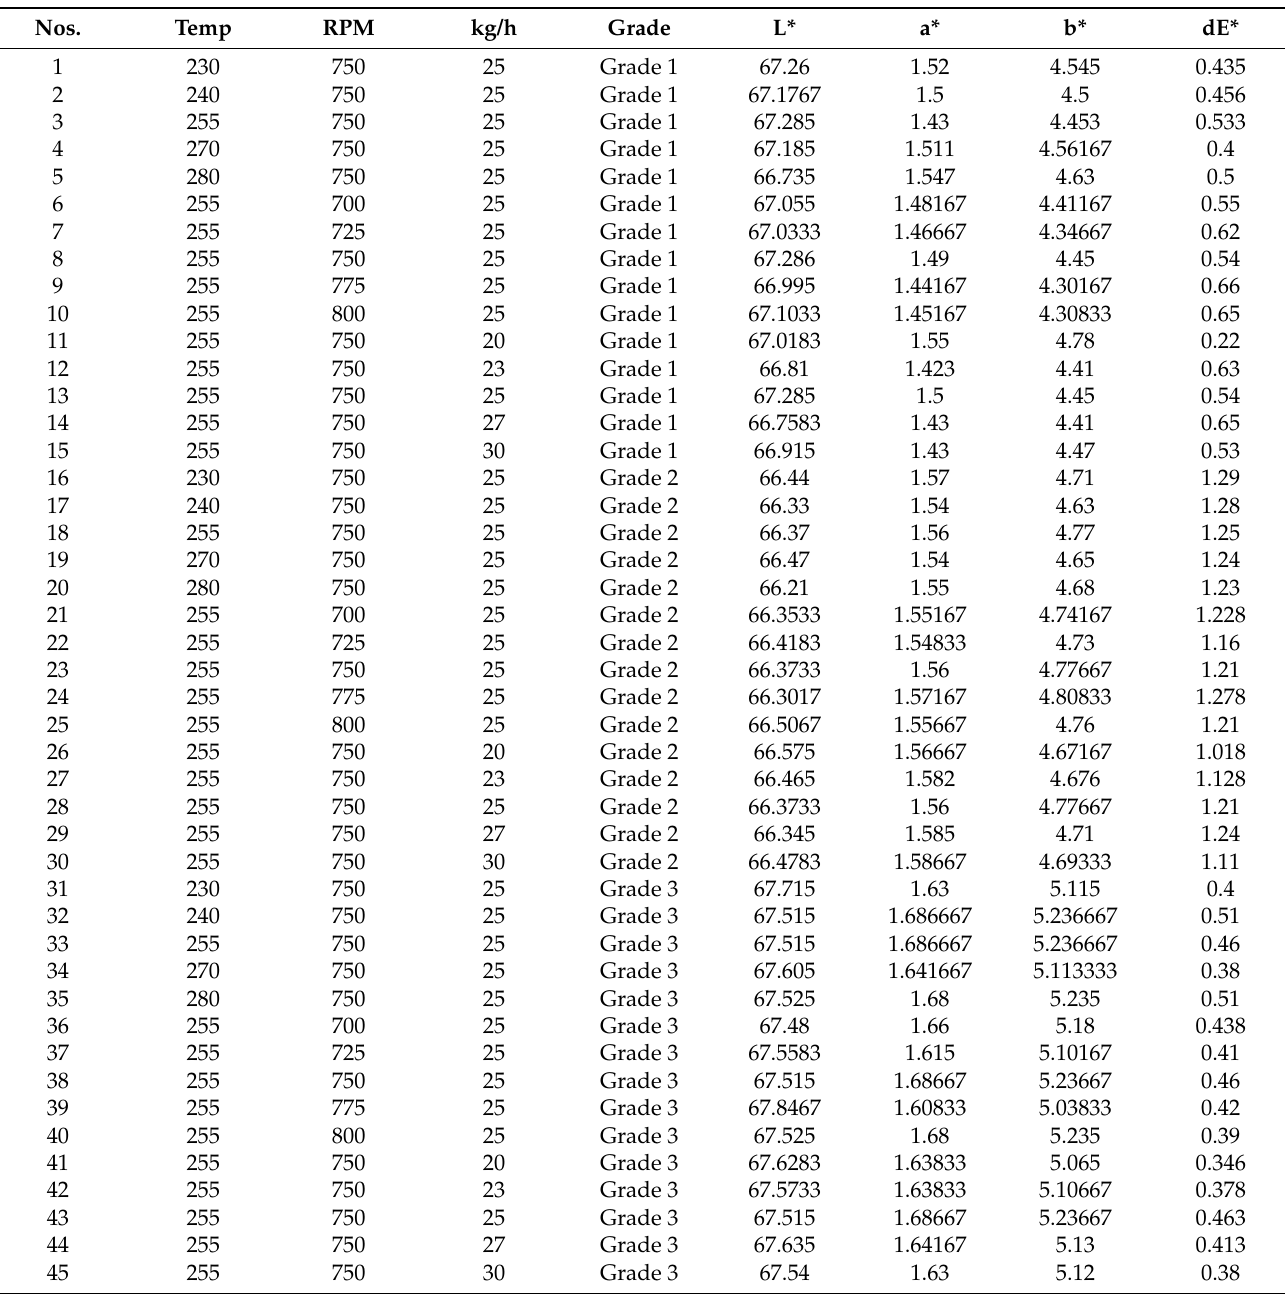
Table 2. Response surface design 45 runs for 3